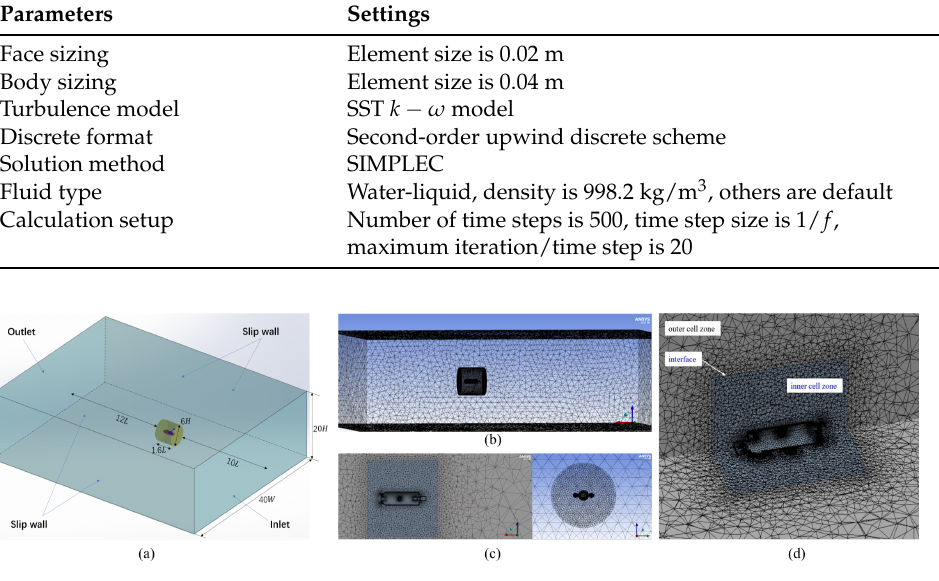
Figure 11. ( a ) Computational fluid domain designed for the PMM test simulation; ( b ) meshing generation of the underwater vehicle model for PMM test simulation; ( c ) closer look of the interface zone; and ( d ) multi-zone fluid domain designed for sliding mesh